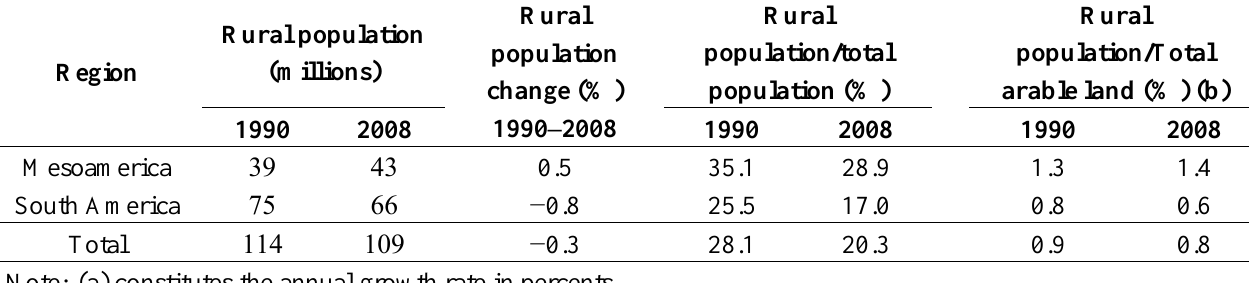
Table 5. Rural population change in Latin